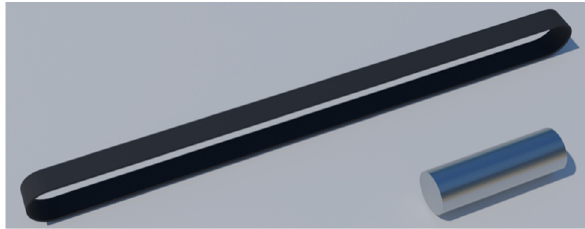
Figure 9. Laminated strap and titanium pin.